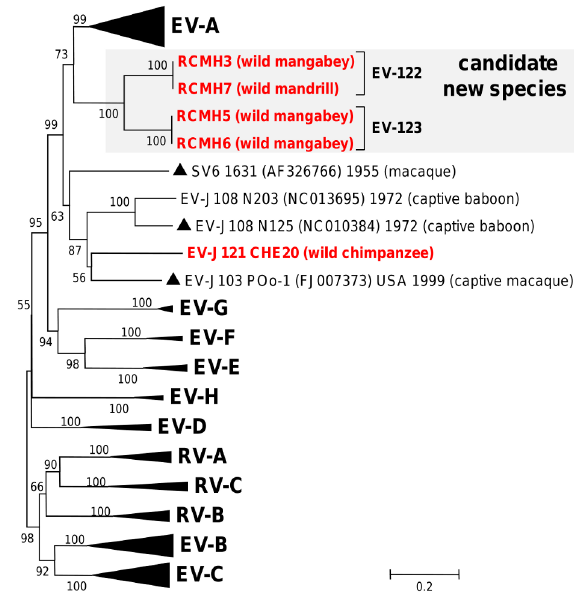
Figure 4. Phylogenetic relationships among the candidate new enterovirus types and species and other known human and animal enteroviruses. Studied viruses from non-human primates are highlighted in bold red with host names indicated in brackets. For clarity most species clusters have been collapsed. The scale is shown at the bottom as substitutions per site.